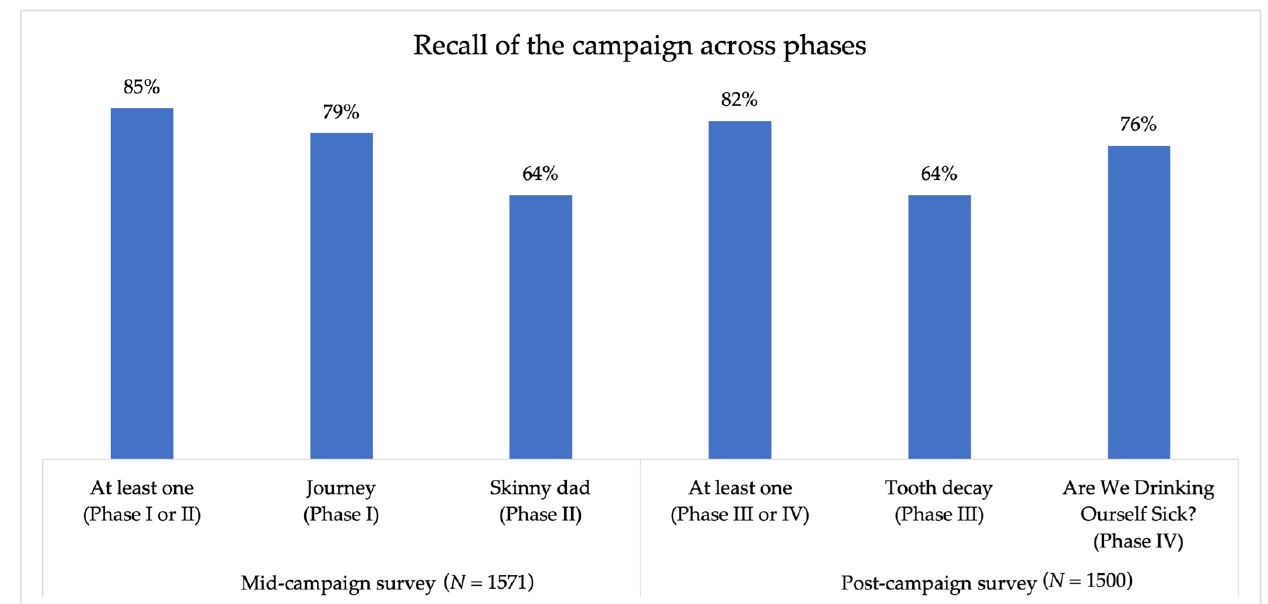
Figure 4. Recall of the “ Are We Drinking Ourselves Sick? ” campaign across phases.